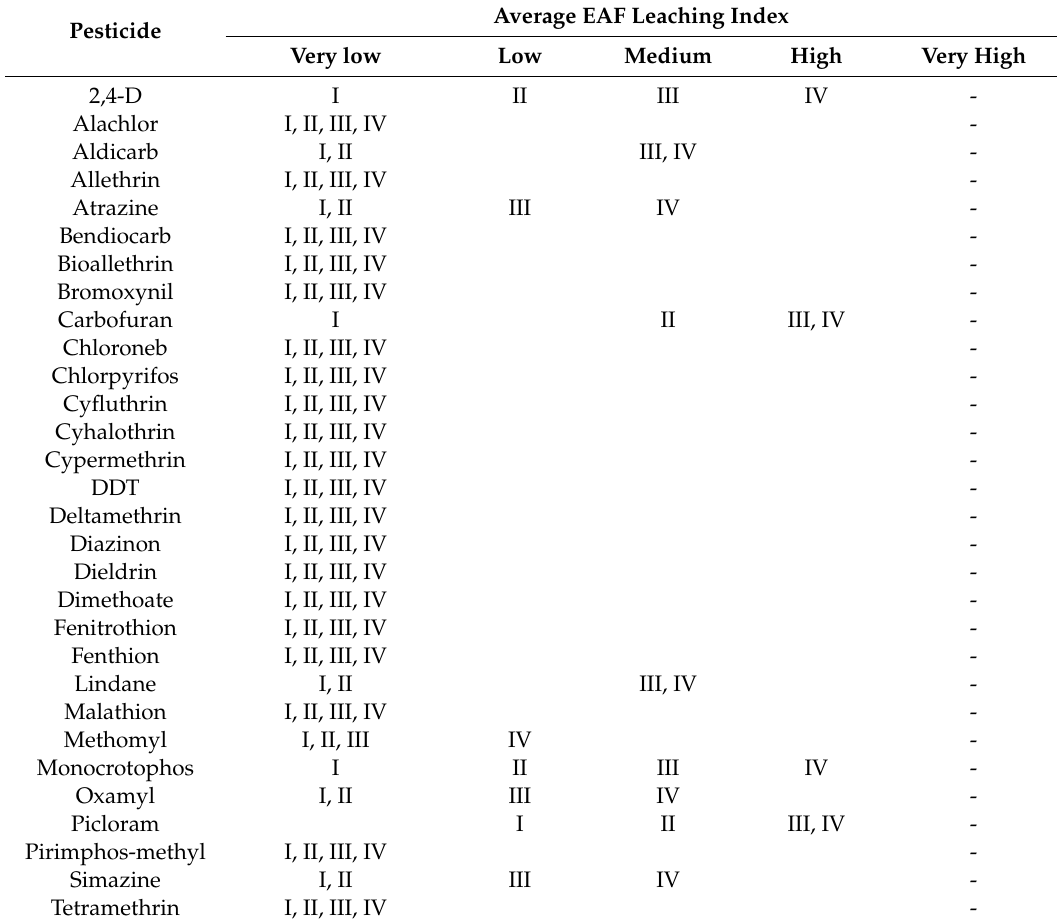
Table 3. E ff ect of leaching scenarios on average leaching potential of pesticides in Jazan watershed.